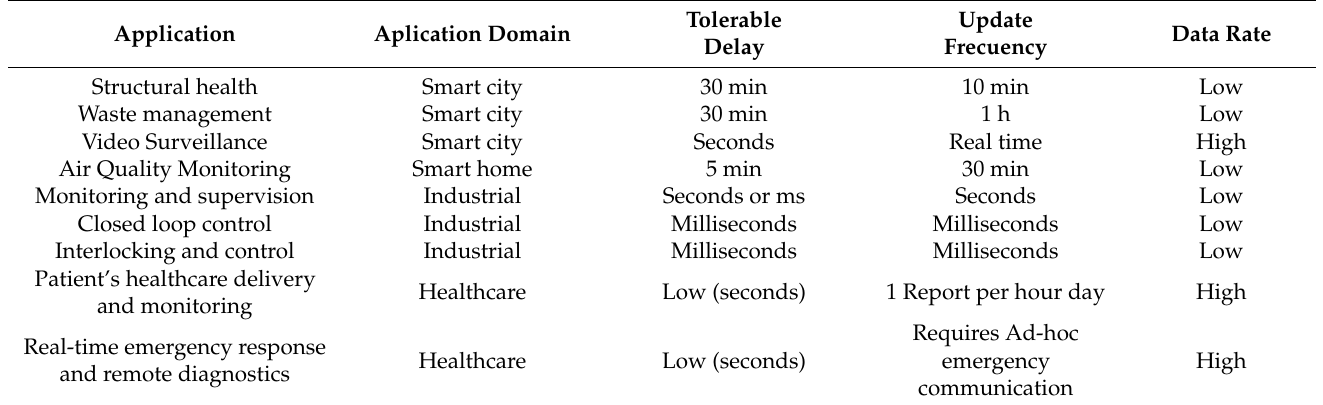
Table 1. General description of features/typical IoT application